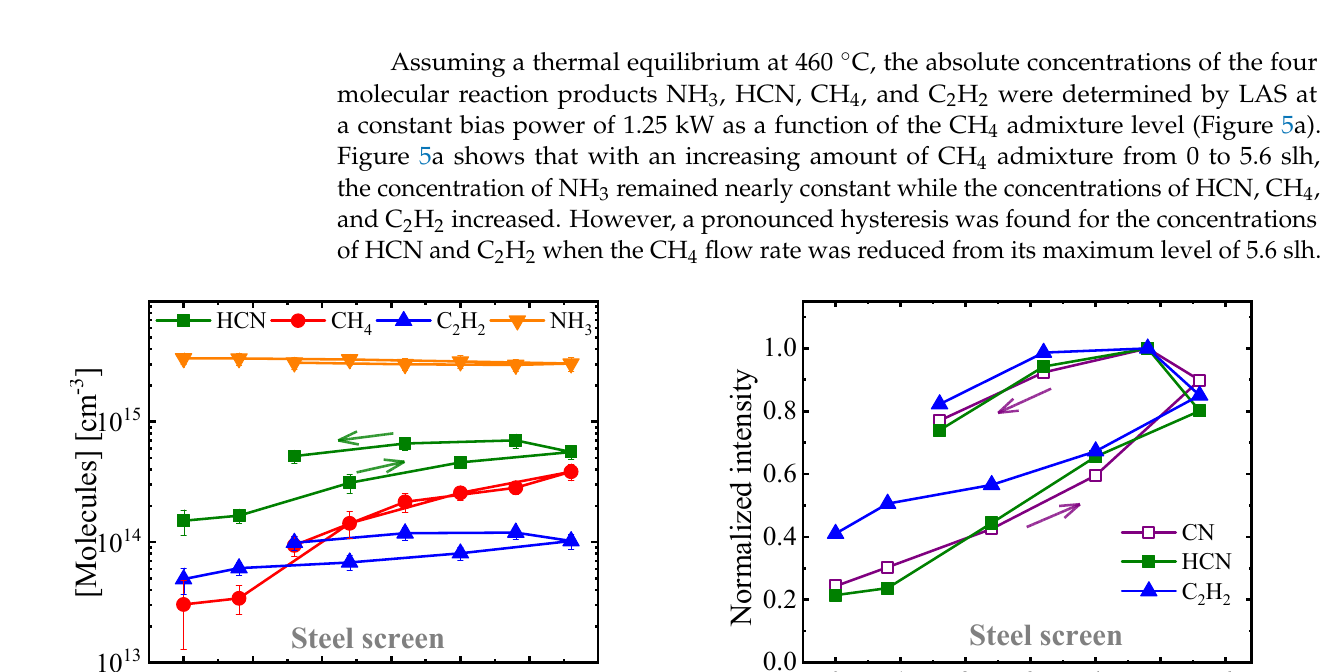
( b ) Low resolution Figure 4. Development of peak intensities with variation of CH 4 admixture level recorded with high- ( a ) and low- resolution ( b ) spectrometers during ASPNC treatment using a steel AS at H 2 :N 2 = 1:1, p = 3 mbar, T = 460 °C, Φ Total = 80 slh, and P Bias = 1.25 kW. Lines are guides for the eye and arrows indicate the order of measurements.